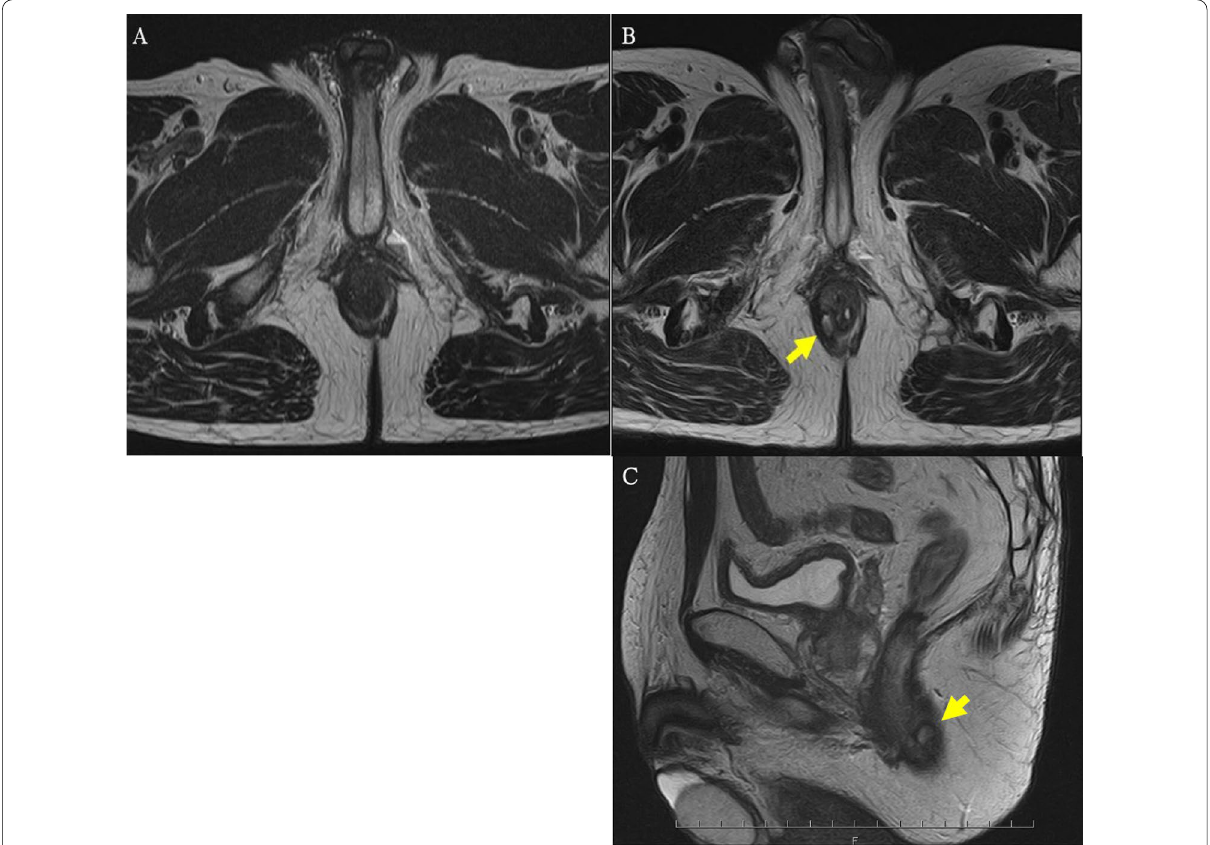
Fig. 2 T2-weighted magnetic resonance imaging of the anal fistula. A Image obtained before preoperative chemoradiation therapy. No anal fistulas are observed. B , C Image shows a high-intensity anal fistula after chemoradiation therapy, located from the anal crypt to the skin behind the anus